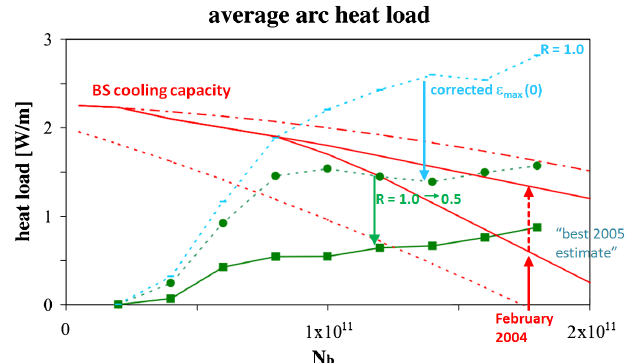
FIG. 7. Simulated average arc heat load per meter for (cid:1) (cid:3) max ¼ ¼ 235 eV illustrating the effect of model changes to 1 : 3 , " (cid:3) max the angular dependence of " max and to the elastic reflection probability, for (cid:1) (cid:3) max ¼ 1 : 3 and " (cid:3) max ¼ 235 eV , as well as the old [23] and updated predictions [24] for the available cooling